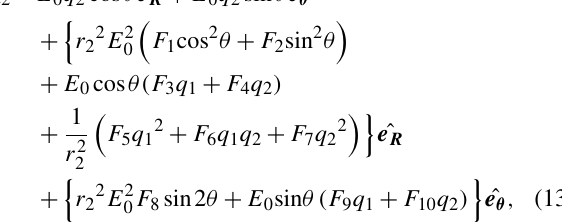
Figure 2 is a schematic diagram showing the forces acting on each droplet in a pair. Also shown in Fig. 2 is the velocity of each droplet relative to the flow, if there are no other droplets present ( v ), and the flow velocity induced by the other droplet ( u ). Droplet velocity relative to the flow is v − u . The electric field E 0 is in the downward direction, which is the same as gravity. Droplet 1 has a positive charge and droplet 2 has a negative charge in this example. The forces acting on each droplet include gravity, flow drag force, and the electrostatic force, as seen on the right side of Eq. (4). For droplet 1, the electric force directly from the external field is in the down- ward direction and is shown as E 0 q 1 in the figure. The in- teractive electric force from droplet 2, shown as F inter in the figure, has a radial component and a tangential component, so that it is in a direction that does not necessarily align with the line connecting the two droplets. Because of the interac- tive electric force from droplet 2, the velocity v of droplet 1 is not in the vertical direction. The electrostatic force between charged droplets tends to make the droplets attract each other. This force is particularly strong when droplets are close to each other, thus enhancing collisions. The flow drag force on droplet 1 is in the opposite direction with v − u